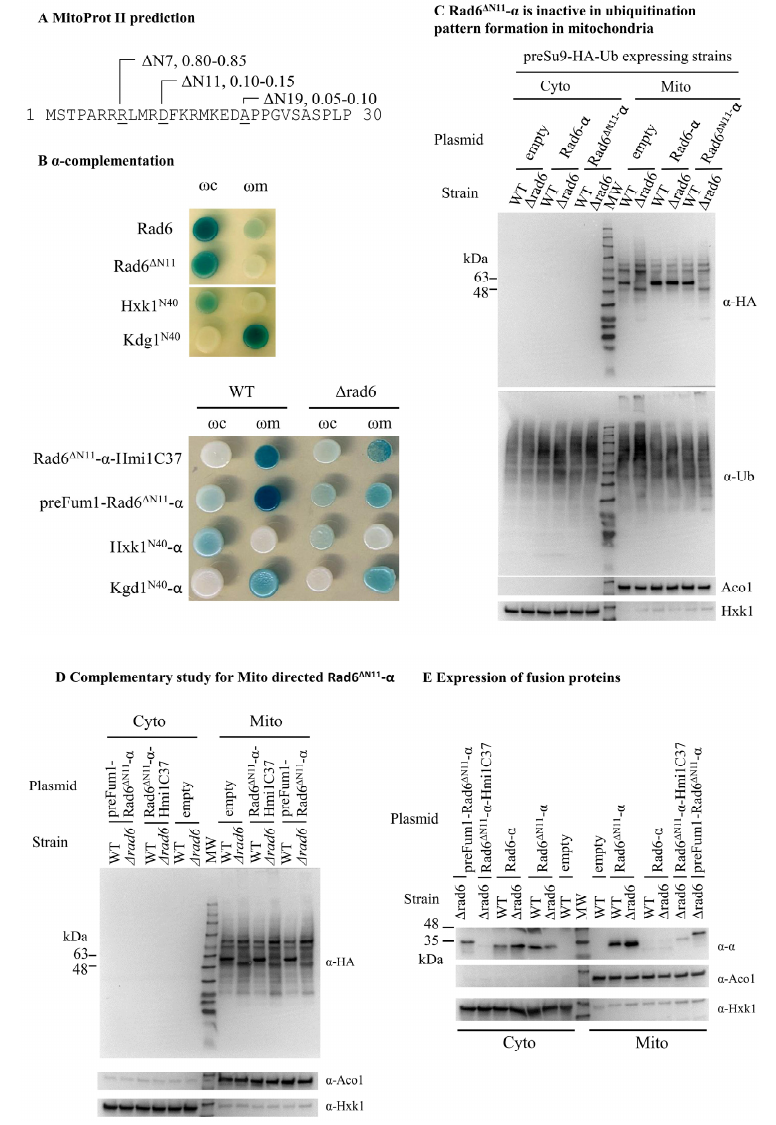
Figure 8. N-terminal amino acids of Rad6 are necessary for its activity in mitochondria. A. MitoProt II analysis of Rad6 N-terminal truncations at different positions. The Mitoprot II scores of Rad6 with its N-terminus truncated at 7, 11, or 19 amino acids ( ∆ N7, ∆ N11, or ∆ N19) and a methionine at the N terminus. ( B) α -complementation of Rad6 N-terminally truncated by 11 amino acids (Rad6 ∆ N11 - α , and MTS-directed Rad6 ∆ N11 - α ). Rad6 ∆ N11 - α N-terminally fused to the MTS of Fum1 or C-terminally to the MTS of Hmi1 (the last 37 amino acids of the protein) is designated as preFum1-Rad6 ∆ N11 - α and Rad6 ∆ N11 - α -Hmi1C37, respectively. ( C ) Rad6 ∆ N11 - α cannot restore the normal ubiquitination pattern in mitochondria in ∆ rad6 cells. preSu9-HA-Ub conjugates signal was investigated for cytosolic and mitochondrial fractions of preSu9-HA-Ub expressing WT or ∆ rad6 cells harboring indicated plasmids by WB. Blot was also probed for control proteins, Ubiquitin (Ub), Aco1 (mitochondrial marker), and Hxk1 (cytosolic marker). ( D ) MTS-directed Rad6 ∆ N11 cannot restore the normal ubiquitination pattern in the mitochondria of ∆ rad6 cells. preSu9-HA-Ub conjugates signals were investigated for cytosolic (Cyto) and mitochondrial (Mito) fractions of preSu9-HA-Ub expressing WT and ∆ rad6 cells harboring MTS-directed Rad6 ∆ N11 - α or an empty plasmid by WB with α -HA antibodies. Aco1, mitochondrial marker; Hxk1, cytosolic marker. ( E ) Distribution of MTS directed Rad6 ∆ N11 - α between the cytosolic and the mitochondrial fraction. Fusion proteins were probed using an antibody against α -tag, α - α . Aco1, mitochondrial marker; Hxk1, cytosolic